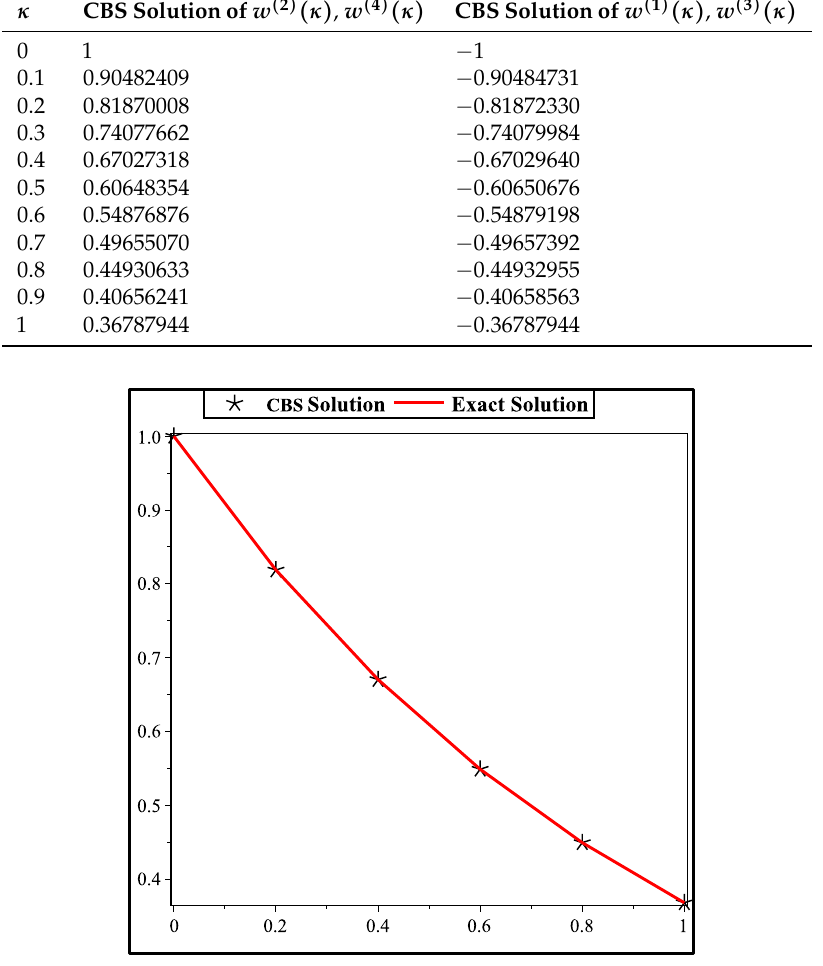
Figure 9. Problem 1 at h = 1